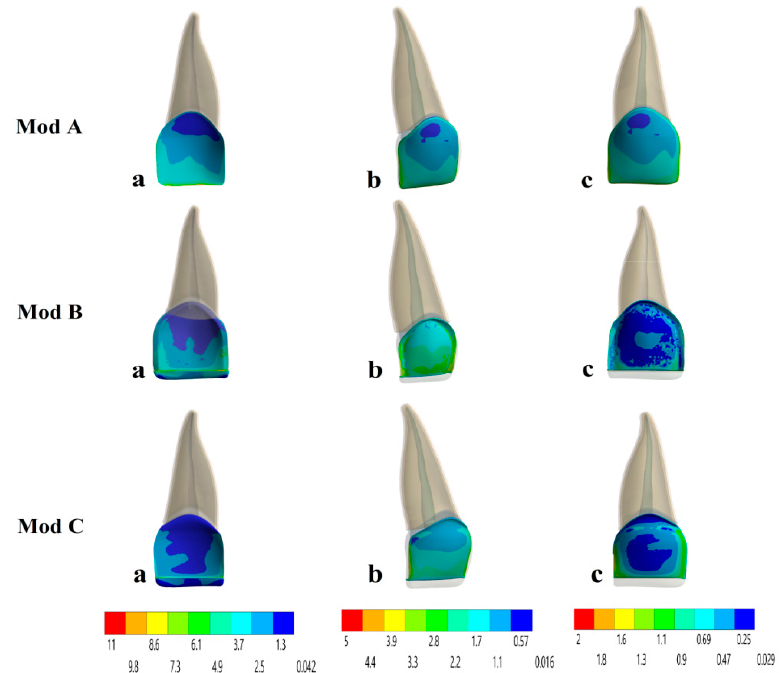
Figure 13. von Mises thermal stress distributions (MPa) in the non-preparation (Mod